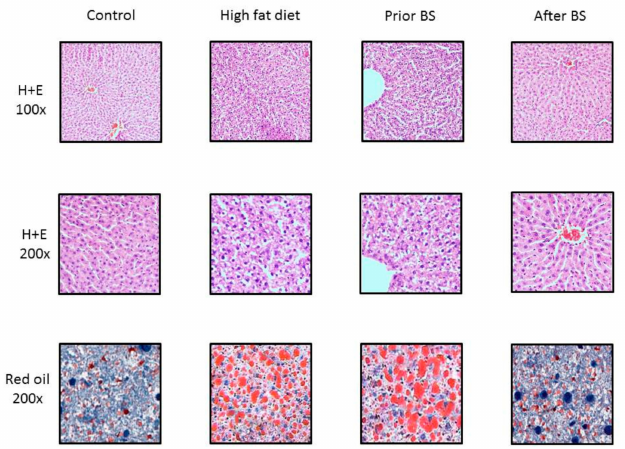
Figure 5. E ff ect of high-fat-diet feeding and bariatric surgery on hepatic steatosis. The photos were made at 100 × and 200 × magnifications. Staining was performed using hematoxilin and eosin (H + E) and red oil. BS—bariatric